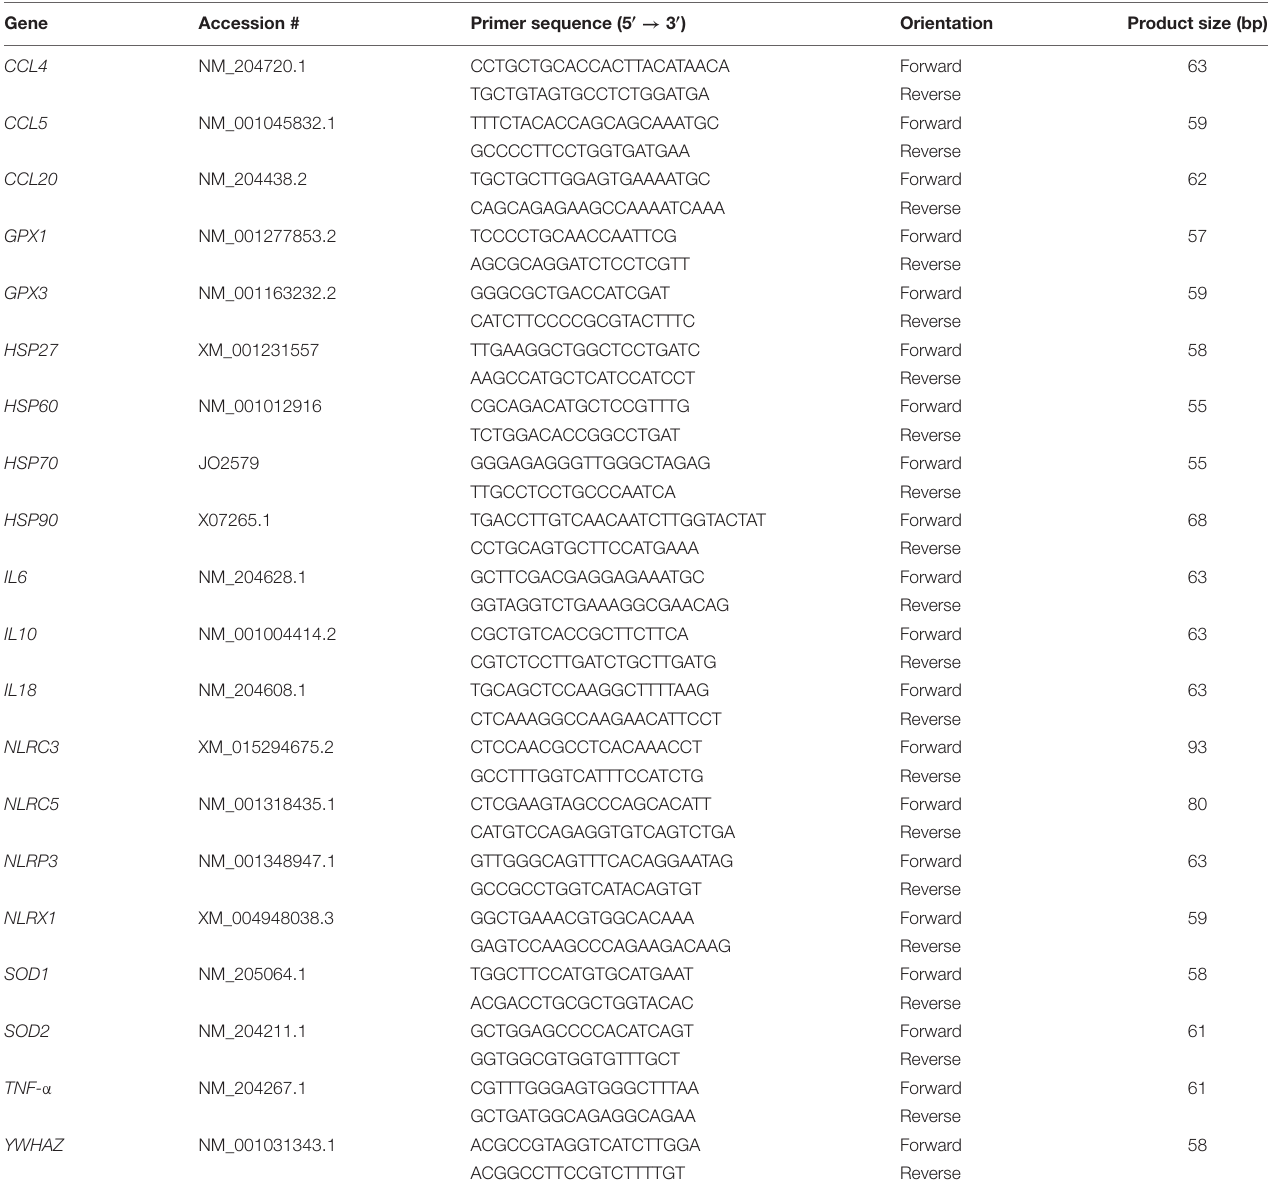
TABLE 2 | Oligonucleotide primers for real-time qPCR. Gene Primer sequence (5 (cid:48) → 3 (cid:48) )